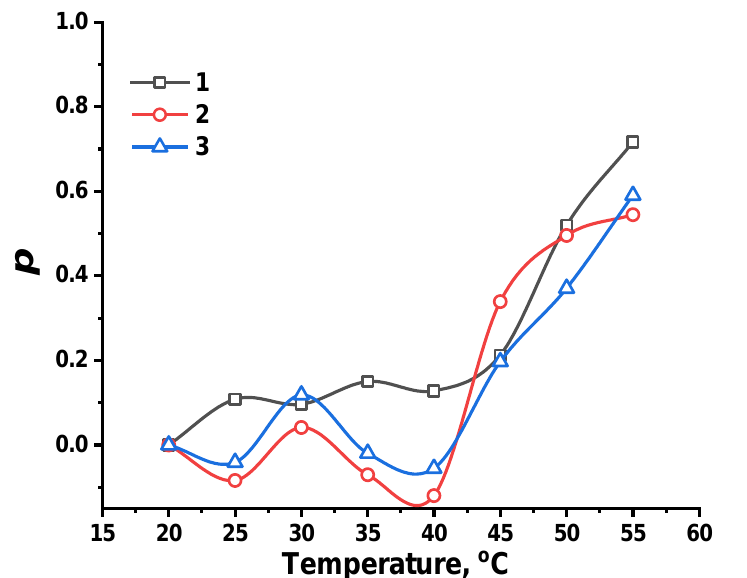
Figure 14. Temperature-dependent volume phase-separated fraction ( p ) for NIPAM-APTAC-AMPS nanogels in D 2 O, with curves (1) NIPAM 90 -APTAC 5 -AMPS 5 ; (2) NIPAM 90 -APTAC 7.5 -AMPS 2.5 ; (3) NIPAM 90 -APTAC 2.5 -AMPS 7.5 .